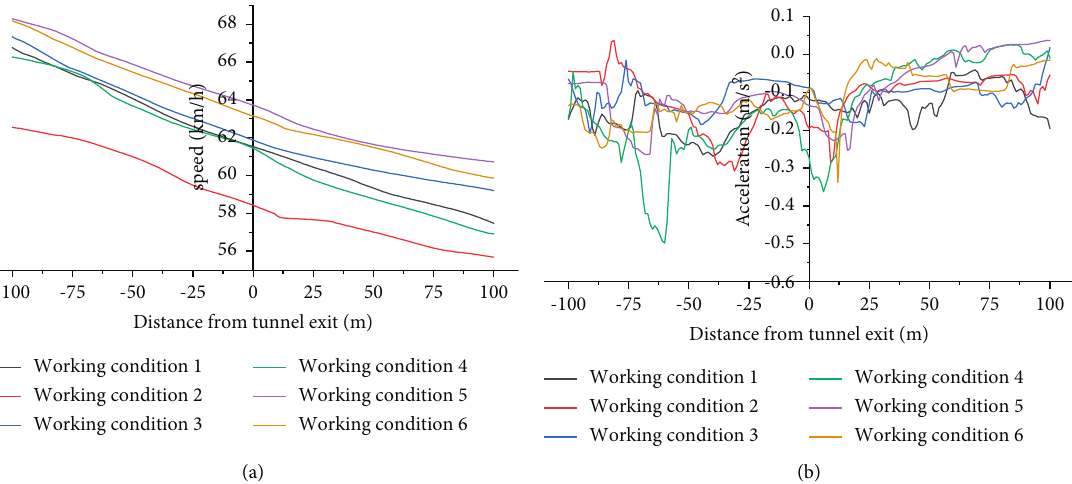
Figure 11: Vehicle speed and acceleration curves within 200m before and after the lane change position in the second service level. (a) Speed curve. (b) Acceleration